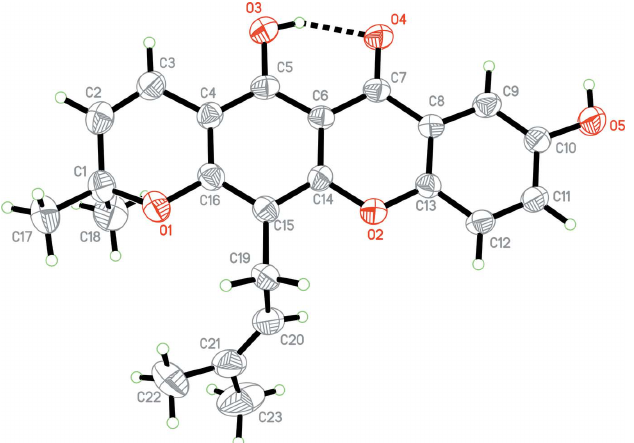
Figure 2 The crystal packing of brasixanthone B viewed along the b -axis direction. Hydrogen bonds are shown as dashed lines. Hydrogen atoms not involved in hydrogen bonds are omitted for clarity.